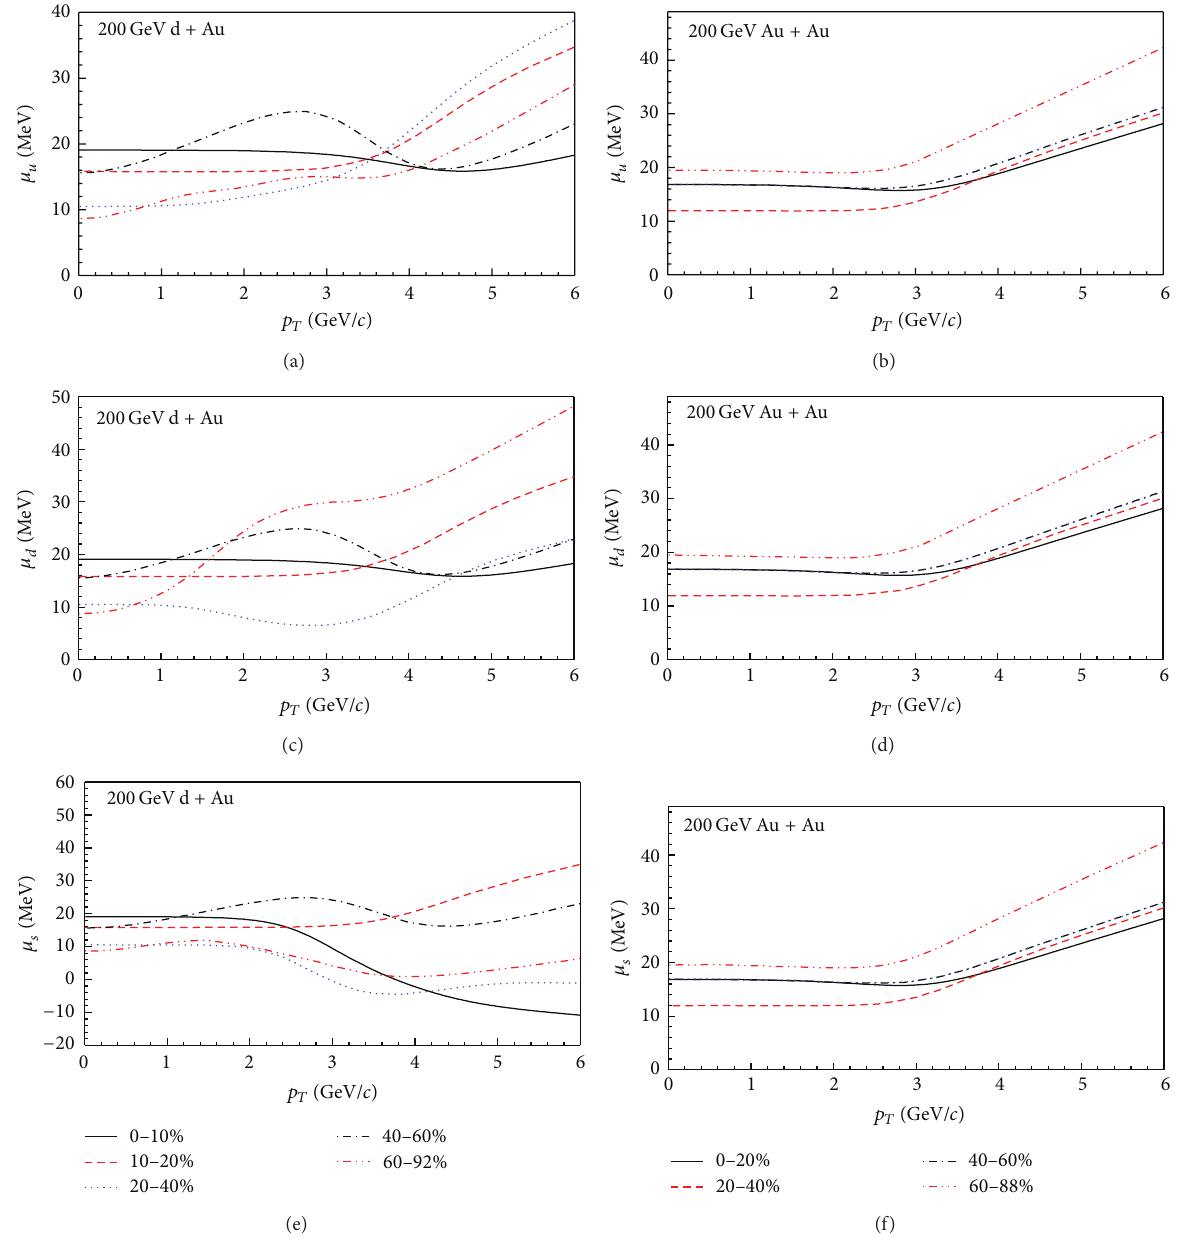
Figure 7: Correlations between 𝜇 ( 𝜇 𝑢 , 𝜇 𝑑 , and 𝜇 𝑠 ) and 𝑝 𝑇 in d-Au and Au-Au collisions at √𝑠 𝑁𝑁 = 200 GeV with different centrality classes. The curves are our calculated